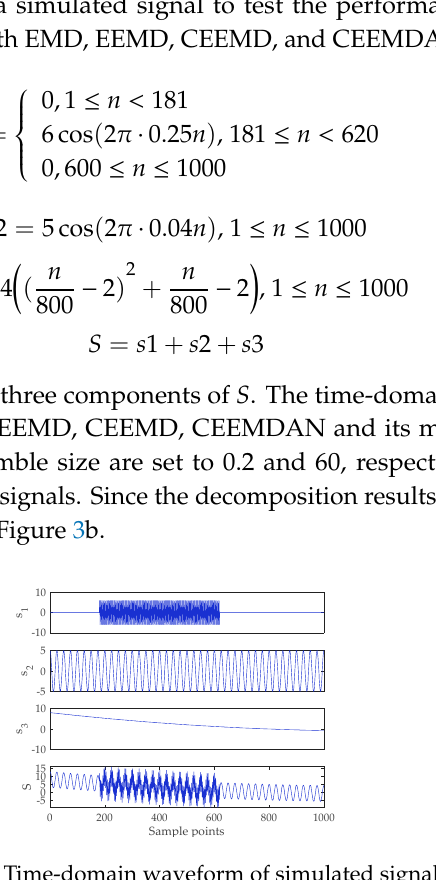
Figure 2. Time-domain waveform of simulated signal.